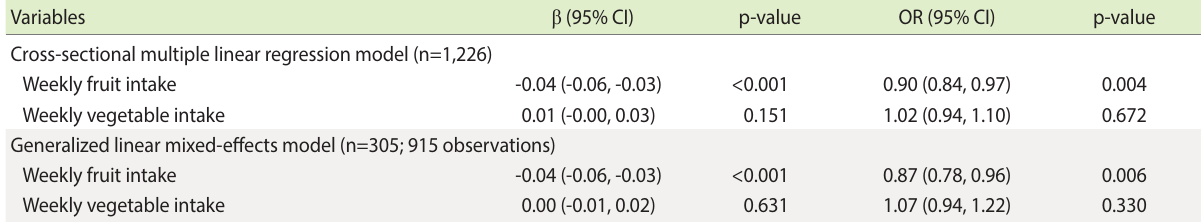
SGDS-K, Korean version of the Short form Geriatric Depression Scale; OR, odds ratio; CI, confidence interval; KRW, Korean won; MET, metabolic equivalents of task. 1 Adjusted for age, sex, education, allowance (10,000 KRW/mo), smoking status, alcohol consumption status, household type, disease status, physi- cal activity (MET min/wk), and body mass